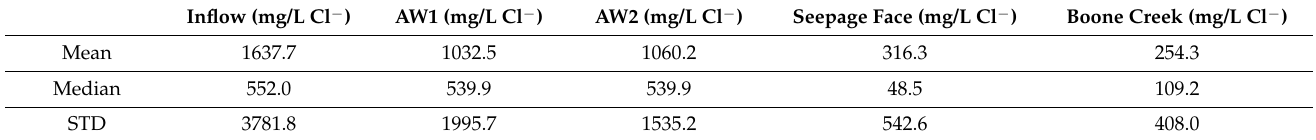
Figure 7. Boxplots of field chloride concentrations at each site throughout the length of the wetland. The middle red line marks the average chloride concentration. Chloride concentrations decrease towards the seepage face. Table 1. Summary of chloride concentration statistics of the field